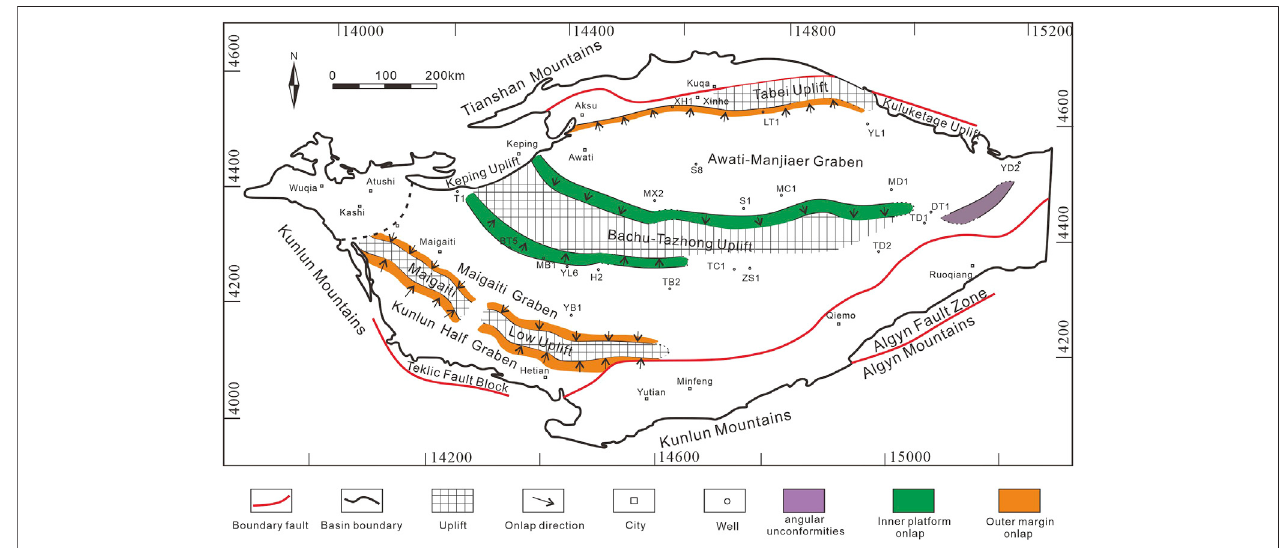
FIGURE 6 | Distribution of unconformity types on the paleotopography in the Tarim Basin.